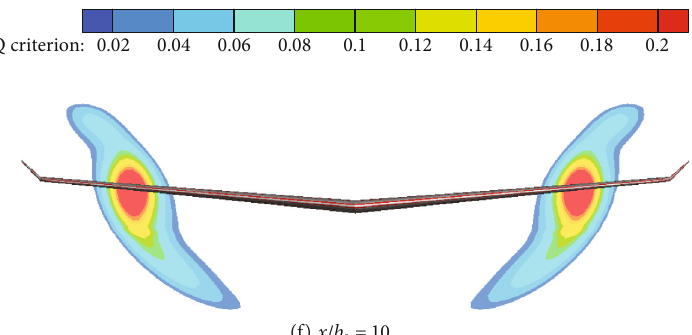
Figure 4: Distribution of Q criterion at 0 – 10 b